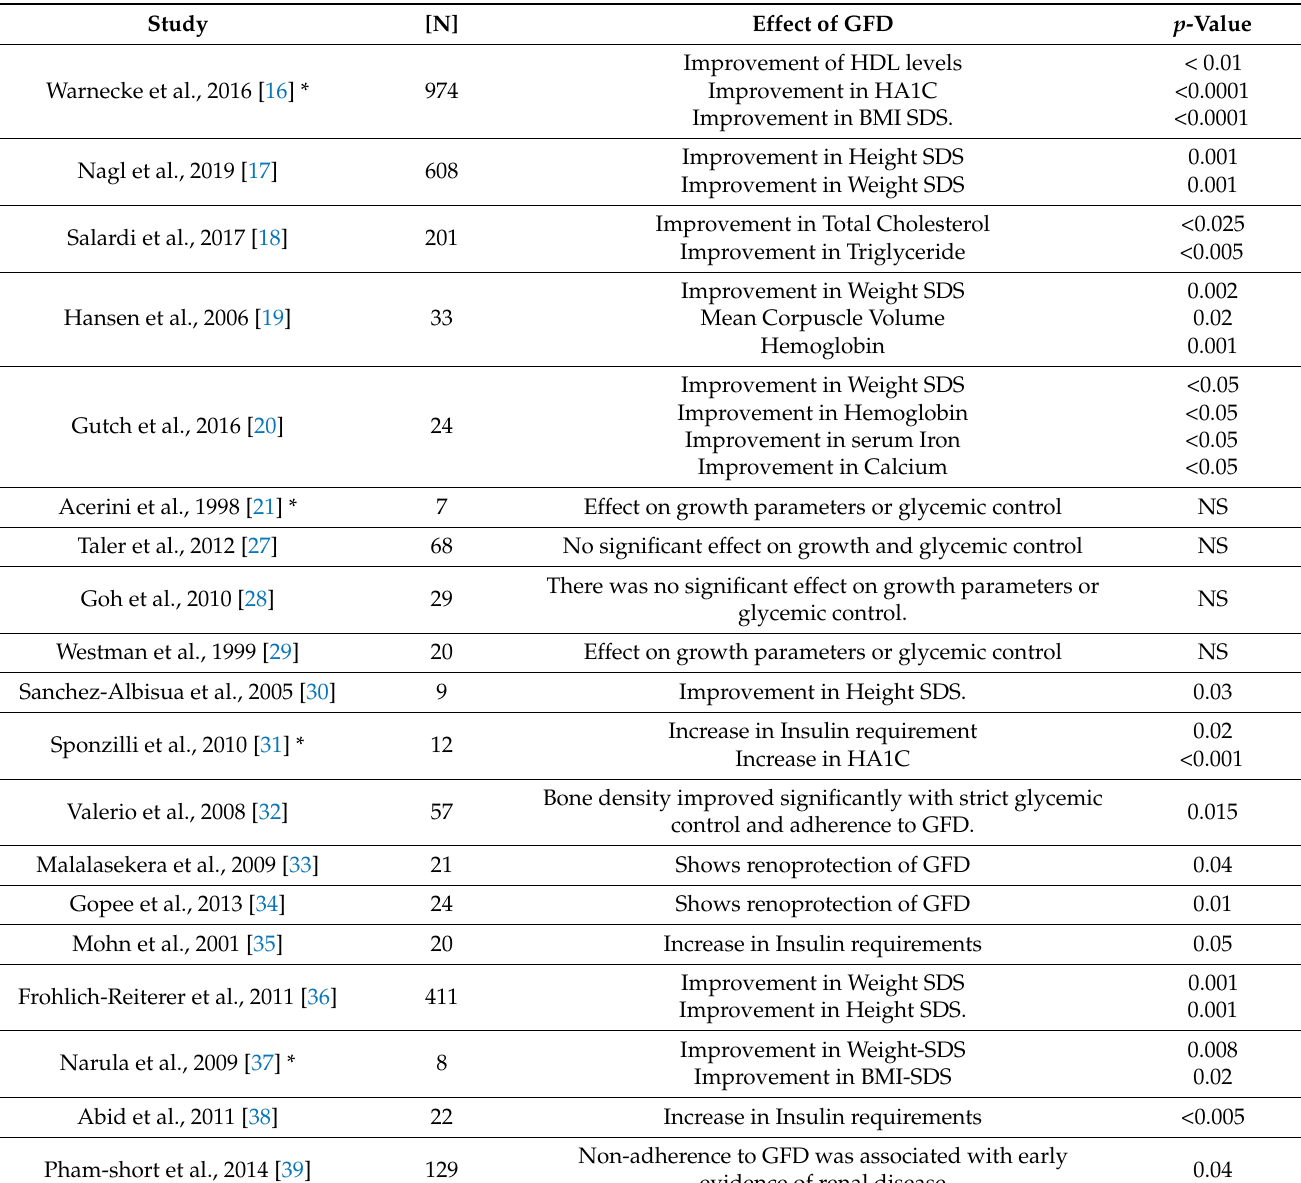
Table 2. Effects of GFD in pediatric patients with a dual diagnosis of T1DM and asymptomatic